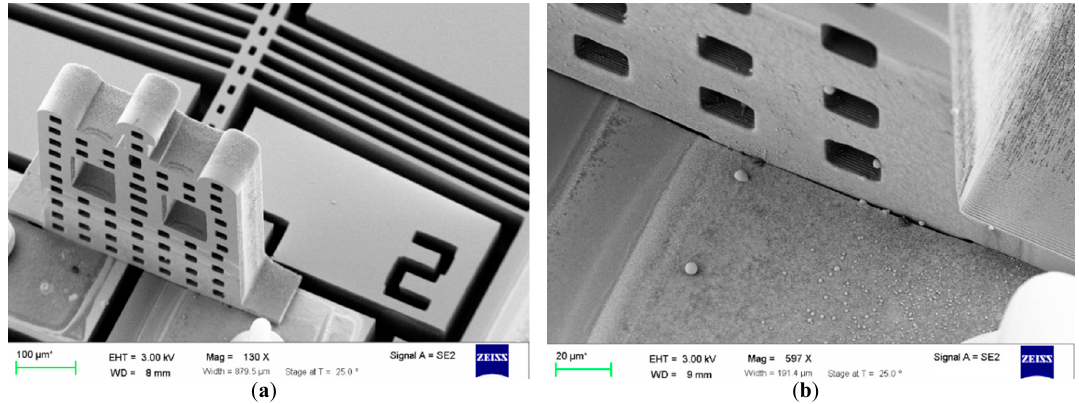
Figure 1. Scaning electron microscopy (SEM) image of a 3D interconnected microelectricomechanical system (MEMS) structures: ( a ) the low magnification image shows the entire structure; and ( b ) the high magnification image shows the area of interest.